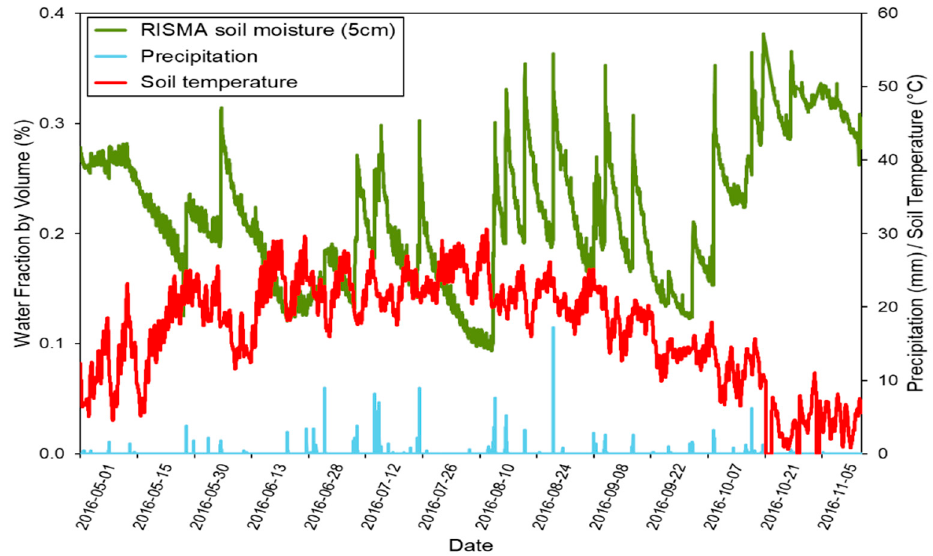
Figure 2. Soil moisture and temperature at 5 cm depth with precipitation records from ON6 RISMA station in 2016.